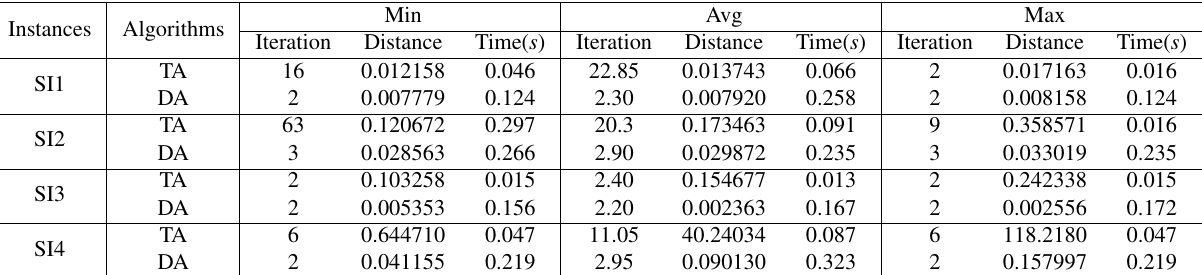
Table 2. The experimental results of the TA and DA algorithms under Case 1